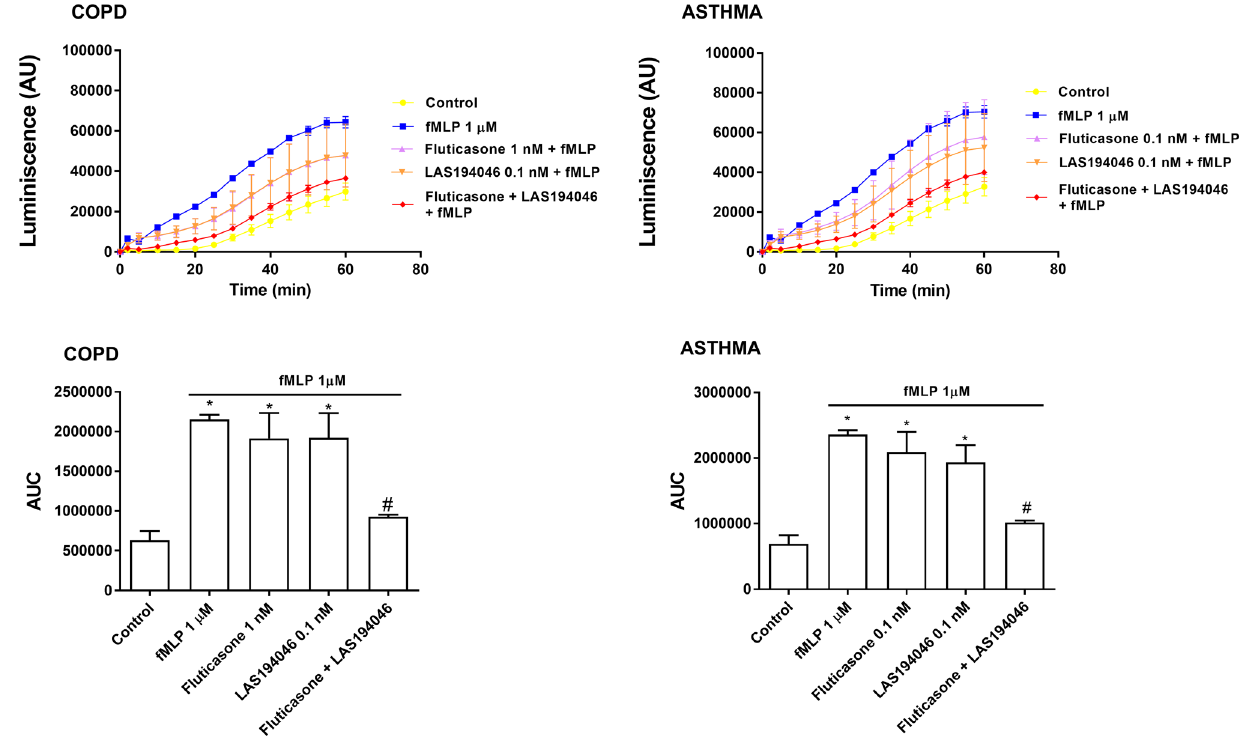
Figure 5. LAS194046 and fluticasone propionate combination shows additive/synergic effects on human neutrophil superoxide anion formation. Neutrophils from severe asthma and COPD patients were pre- incubated with sub-effective concentrations of LAS194046, fluticasone propionate or its combination during 30 min followed by cell stimulation with fMLP (1 µM) for 45 min. The results are expressed as luminescence values [arbitrary units (AU)] and as the area under curve generated by luminescence time-curse data as the mean ± SD (n = 3 each for cells from COPD patients in independent experiments with triplicate samples). A two- way ANOVA was followed by a post hoc Bonferroni test. *p < 0.05 vs. control; # p < 0.05 vs. monotherapy.